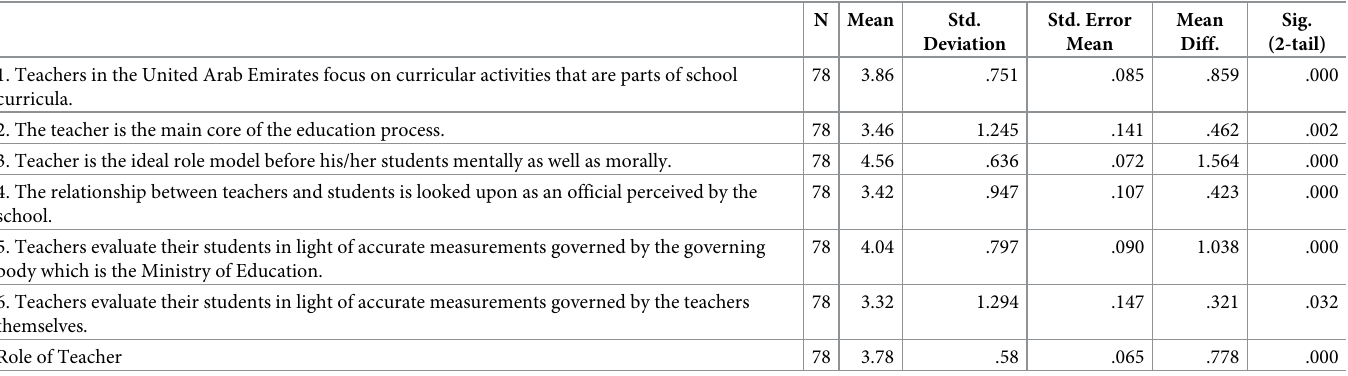
Table 7. One-sample statistics (role of teachers and related items, test value = 3).